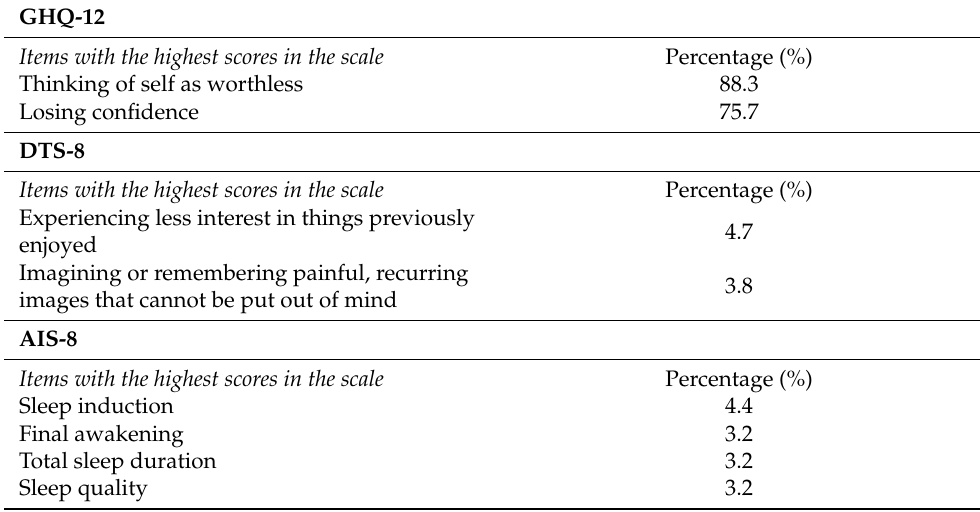
Table 1. Items from the GHQ-12, DTS-8, and AIS-8 instruments with the greatest significance ( n = 317).